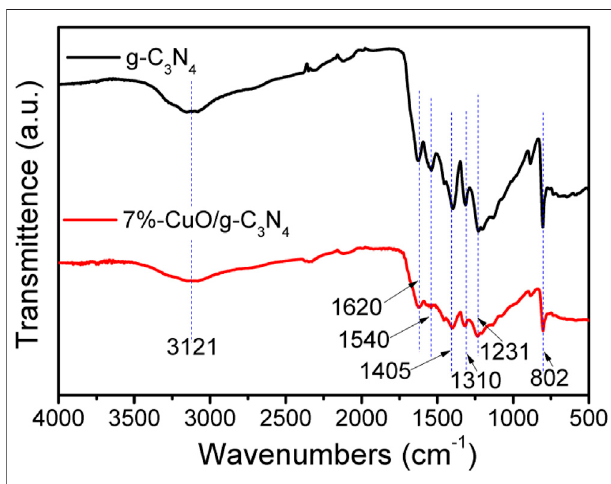
FIGURE 5 | Fourier transform-infrared (FT-IR) spectra of g-C 3 N 4 and 7%-CuO/g-C 3 N 4